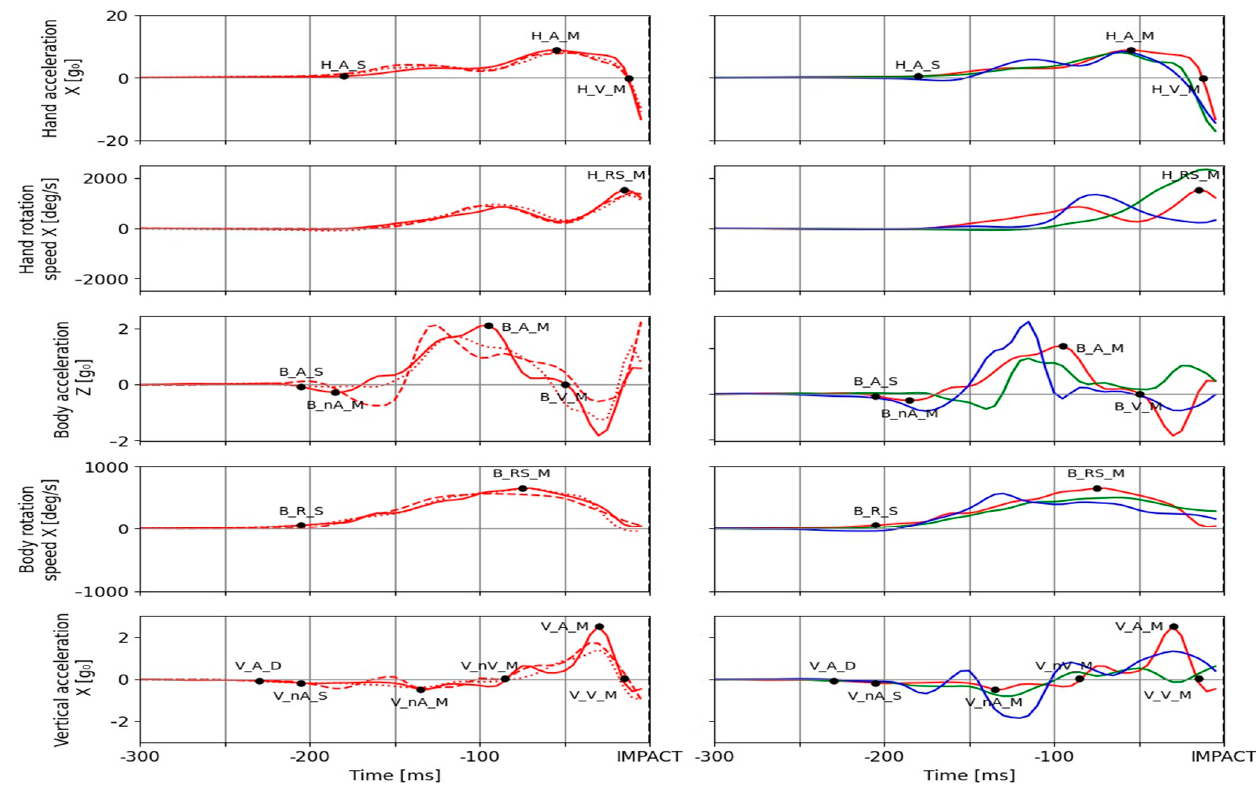
Figure 3. The relevant sensor signals with examined temporal events for the same participant (left) and different participants (right).